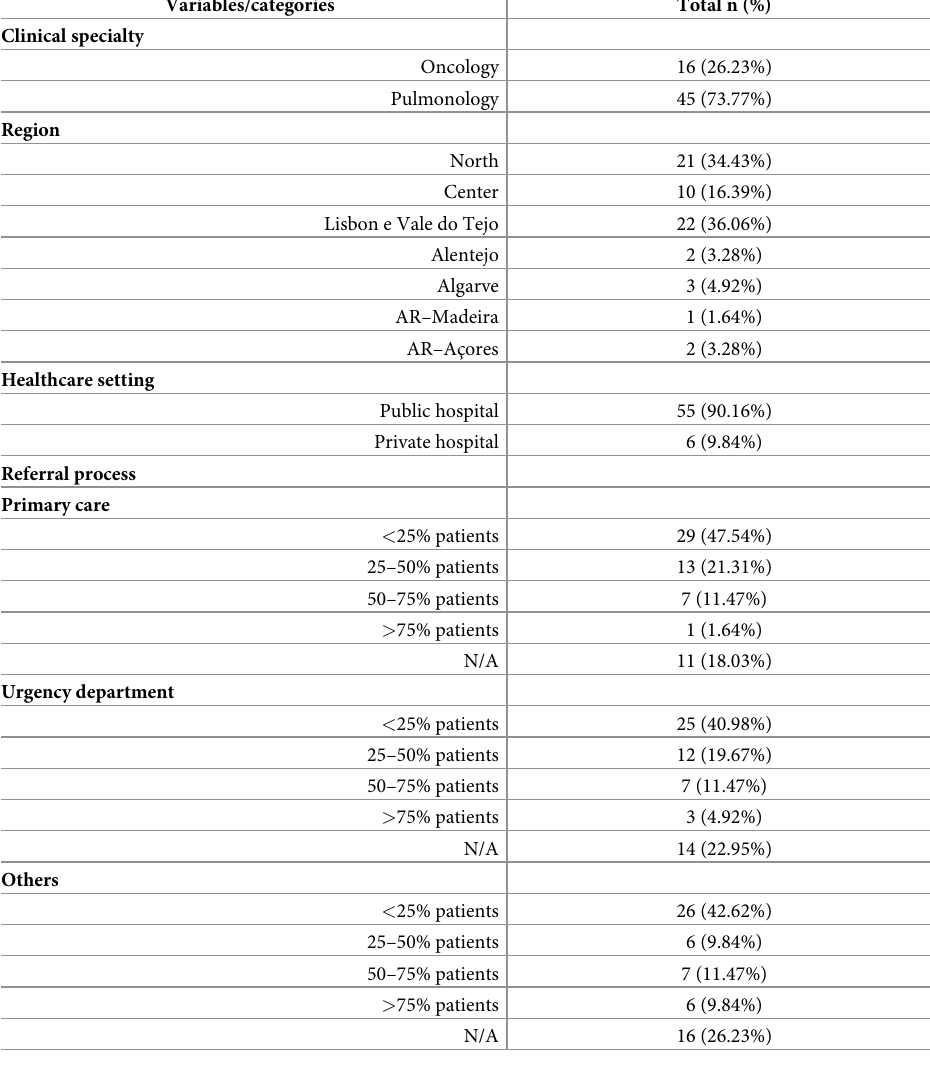
Table 1. Baseline characteristics of 61 physicians in